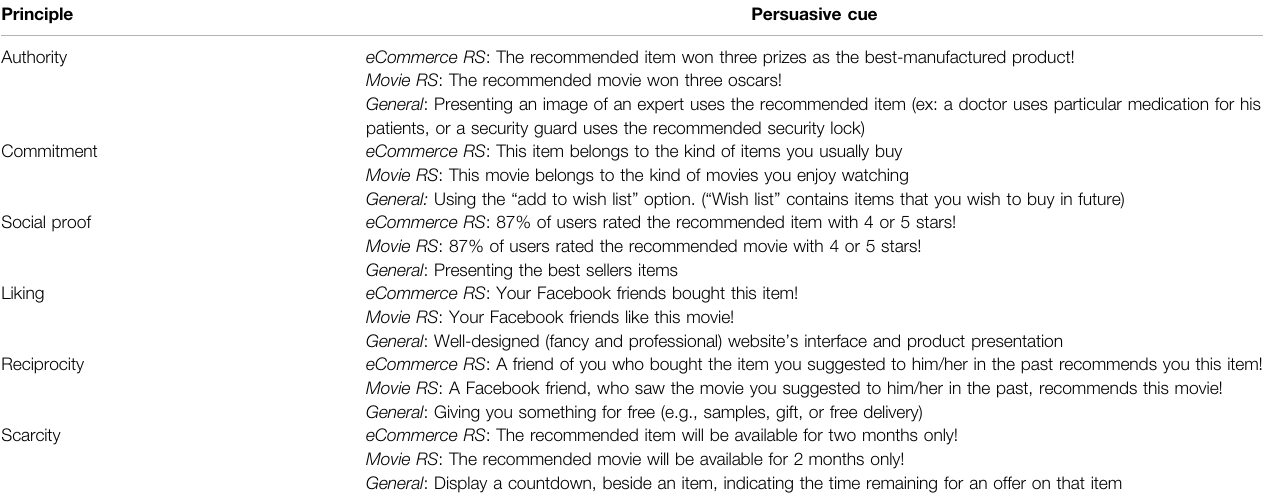
TABLE 2 | Persuasive sentences presented in the questionnaires. Principle Persuasive cue Authority